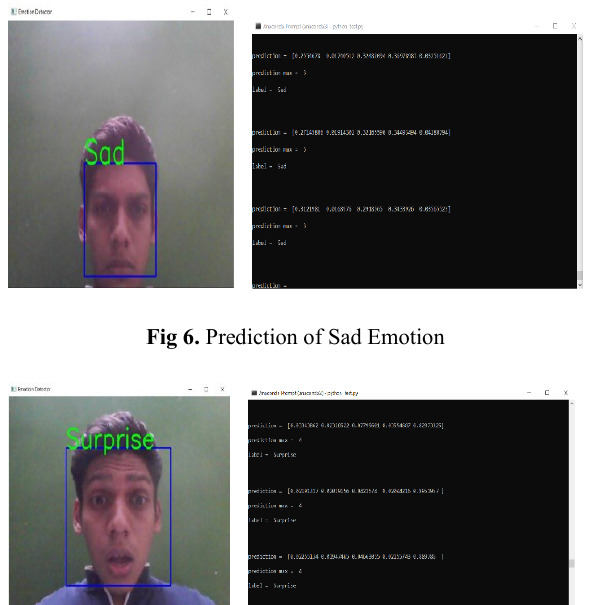
Fig 5. Prediction of Happy Emotion